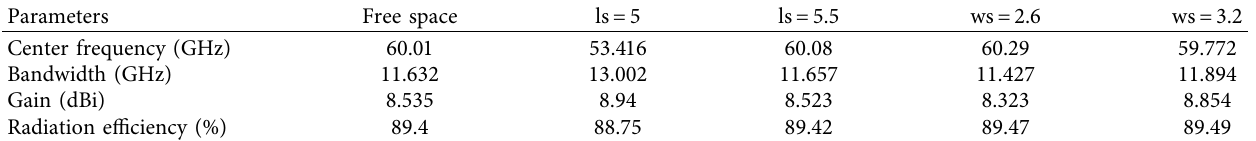
Table 6: Radiator length (ls) and width (ws) change.